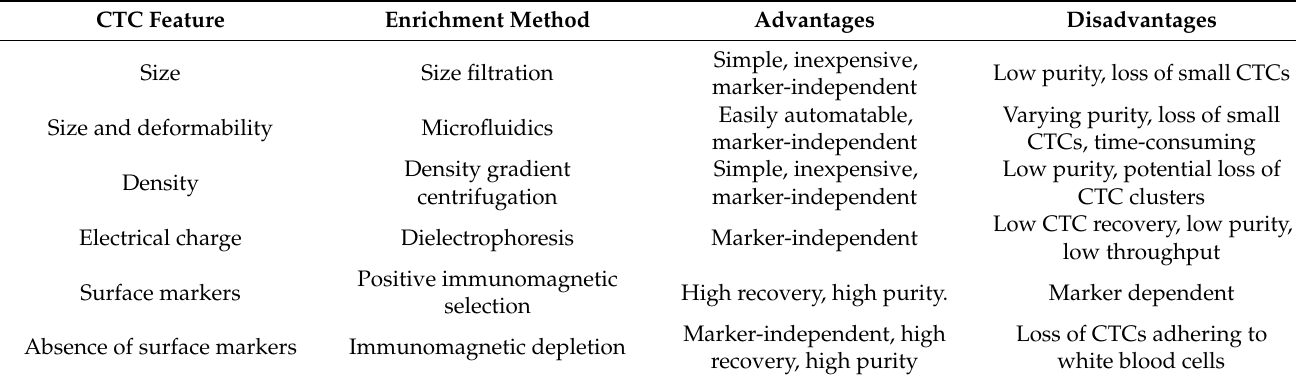
Table 2. Circulating tumor cell (CTC) enrichment